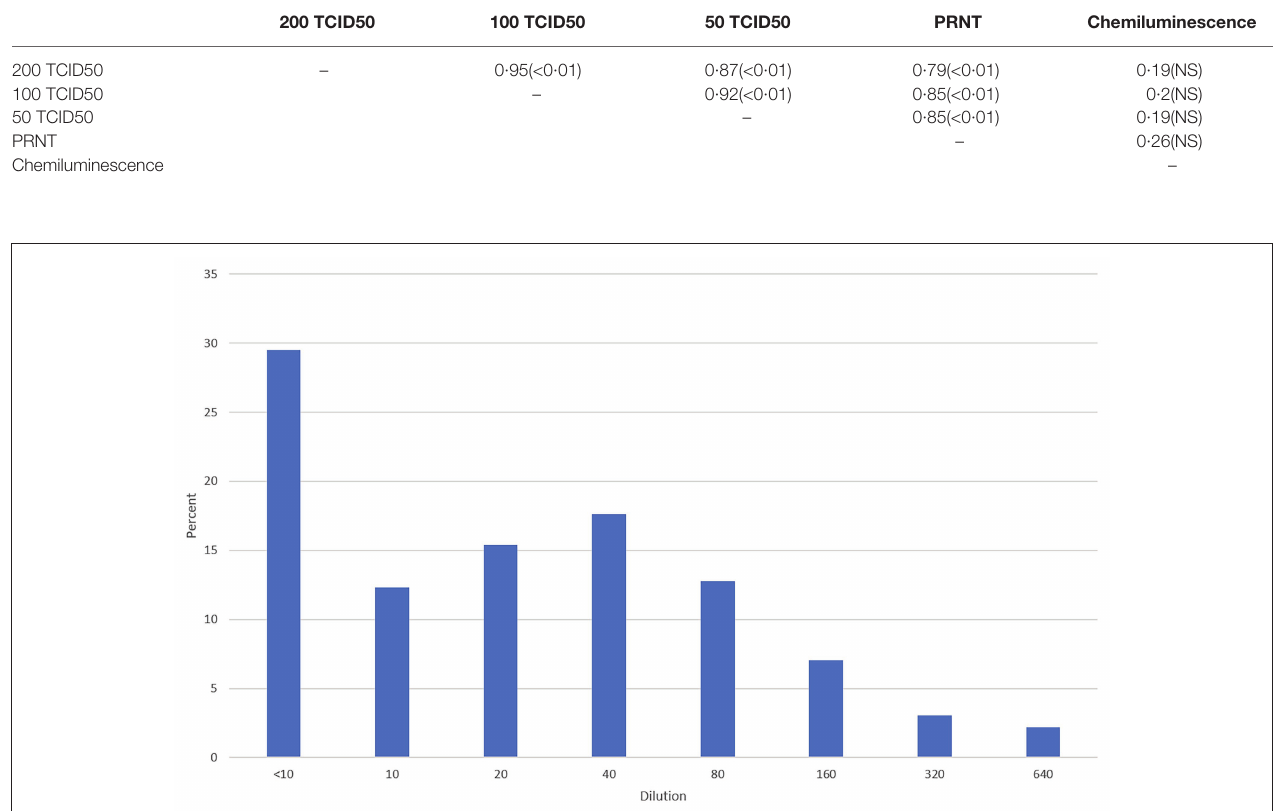
FIGURE 3 | Distribution of titers in all tested plasma samples using the 100 TCID50/ml microneutralization (MN)